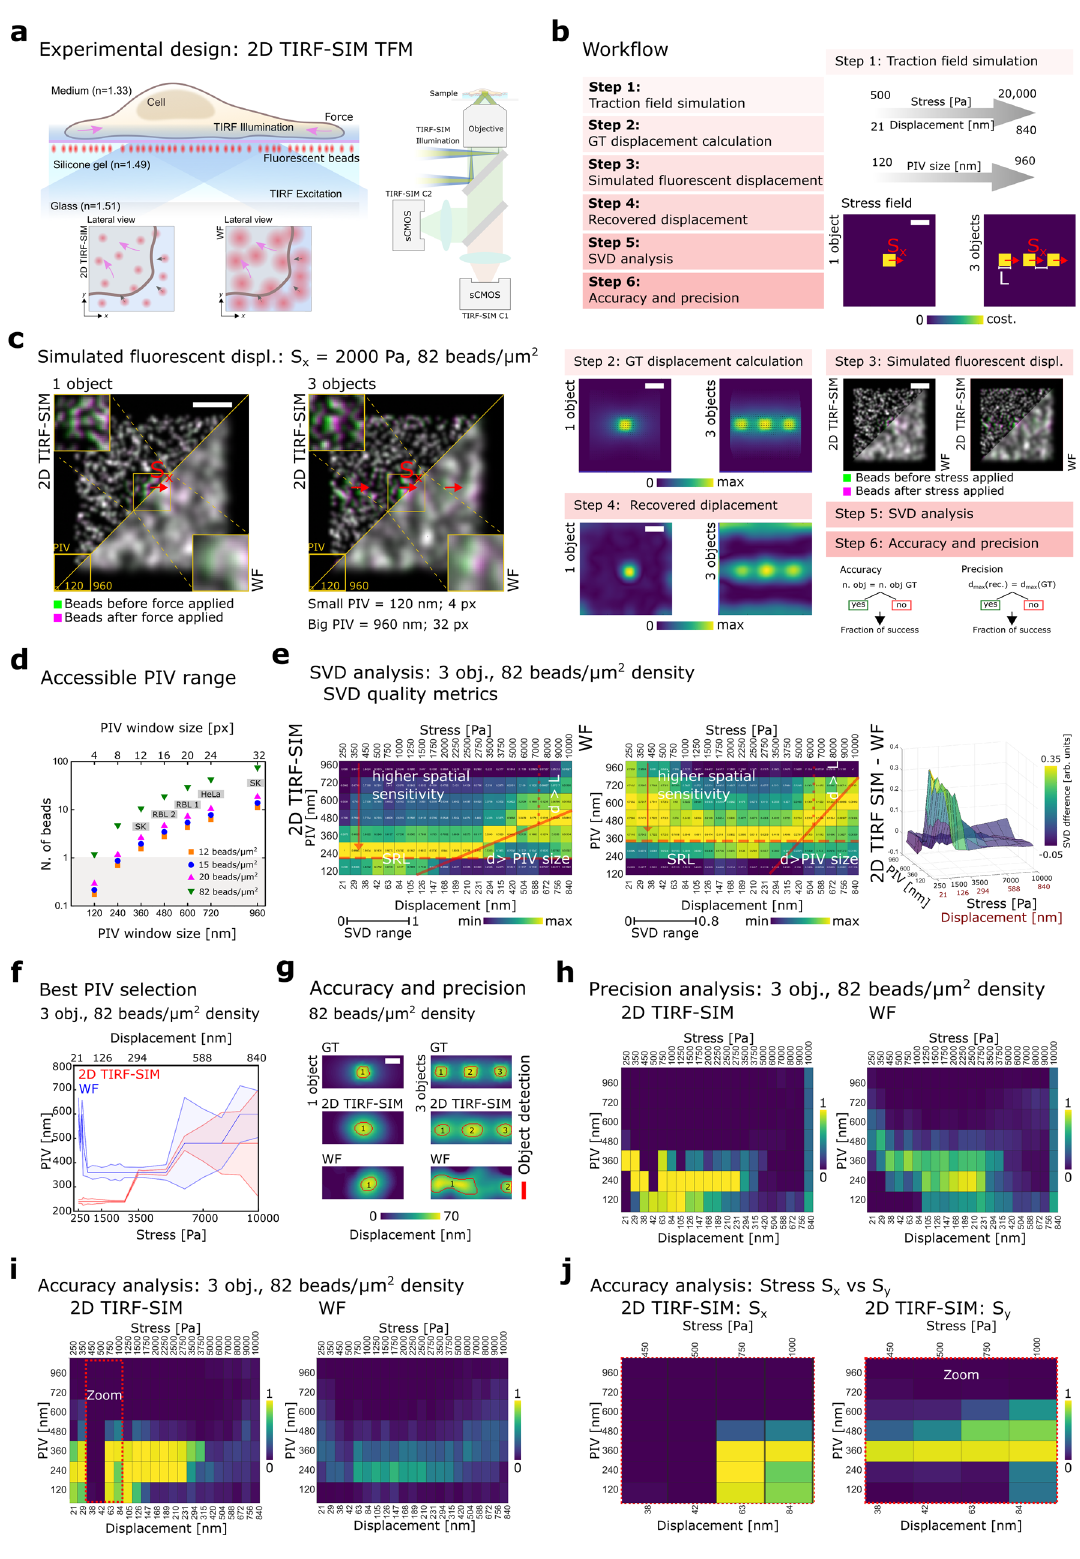
gel sample allowing simultaneous super-resolved acquisition of both the fl uorescent cell and bead channel over time (Fig. 1a). Advantages of TIRF-SIM over 2D SIM image acquisition are all inherent to the isotropic nature of the TIRF point spread function (PSF; <100 ± 20 nm laterally and axially) in contrast to the non-isotropic PSF of 2D SIM (<100 ± 20 nm laterally